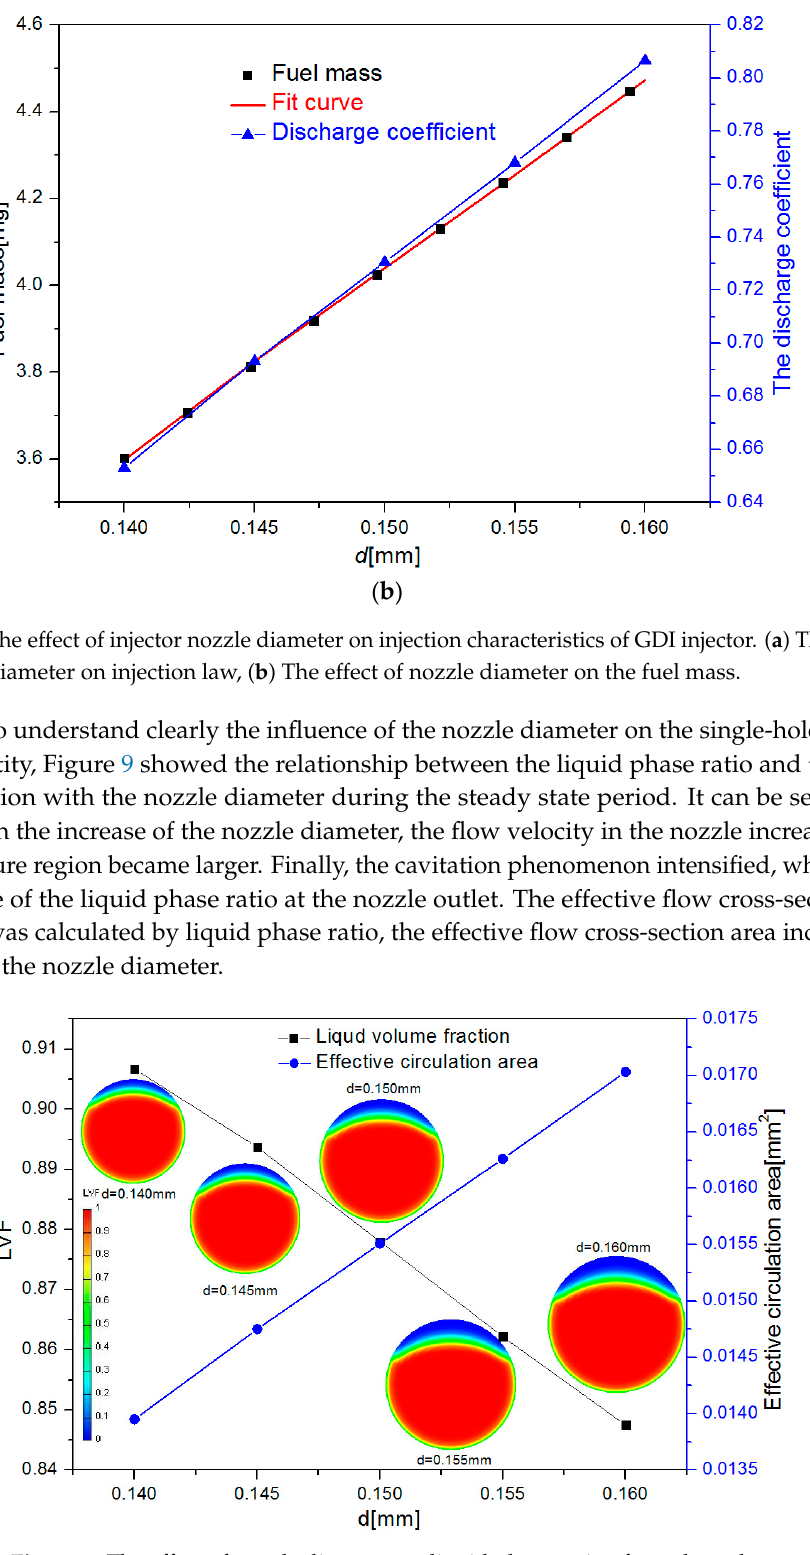
Figure 9. The effect of nozzle diameter on liquid phase ratio of nozzle outlet.